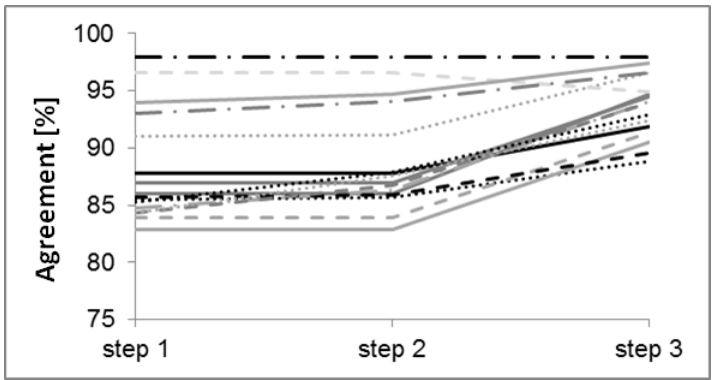
Figure 3. Agreement of the EURAC and Landsat snow cover maps (SCA) map comparisons for different masking steps. Each line represents one of the 16 comparisons (Table 2), while the steps show the agreement for various masking levels, as explained in the text. For